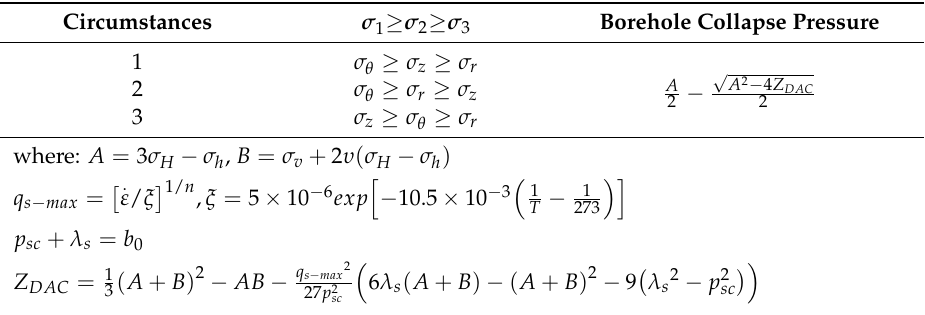
Table 5. Derradji-Aouat criterion for the determination of the fracturing pressure in an ice borehole. Circumstances σ 1 ≥ σ 2 ≥ σ 3 Borehole Fracturing Pressure 1 σ r ≥ σ z ≥ σ θ 2 σ z ≥ σ r ≥ σ θ 3 σ r ≥ σ θ ≥ σ z where: D = 3 σ h − σ H , E = σ v − 2 υ ( σ H − σ h ) (cid:2) . (cid:3) 1/ n q s − max = ε / ξ , ξ = 5 × 10 − 6 exp p sc + λ s = b 0